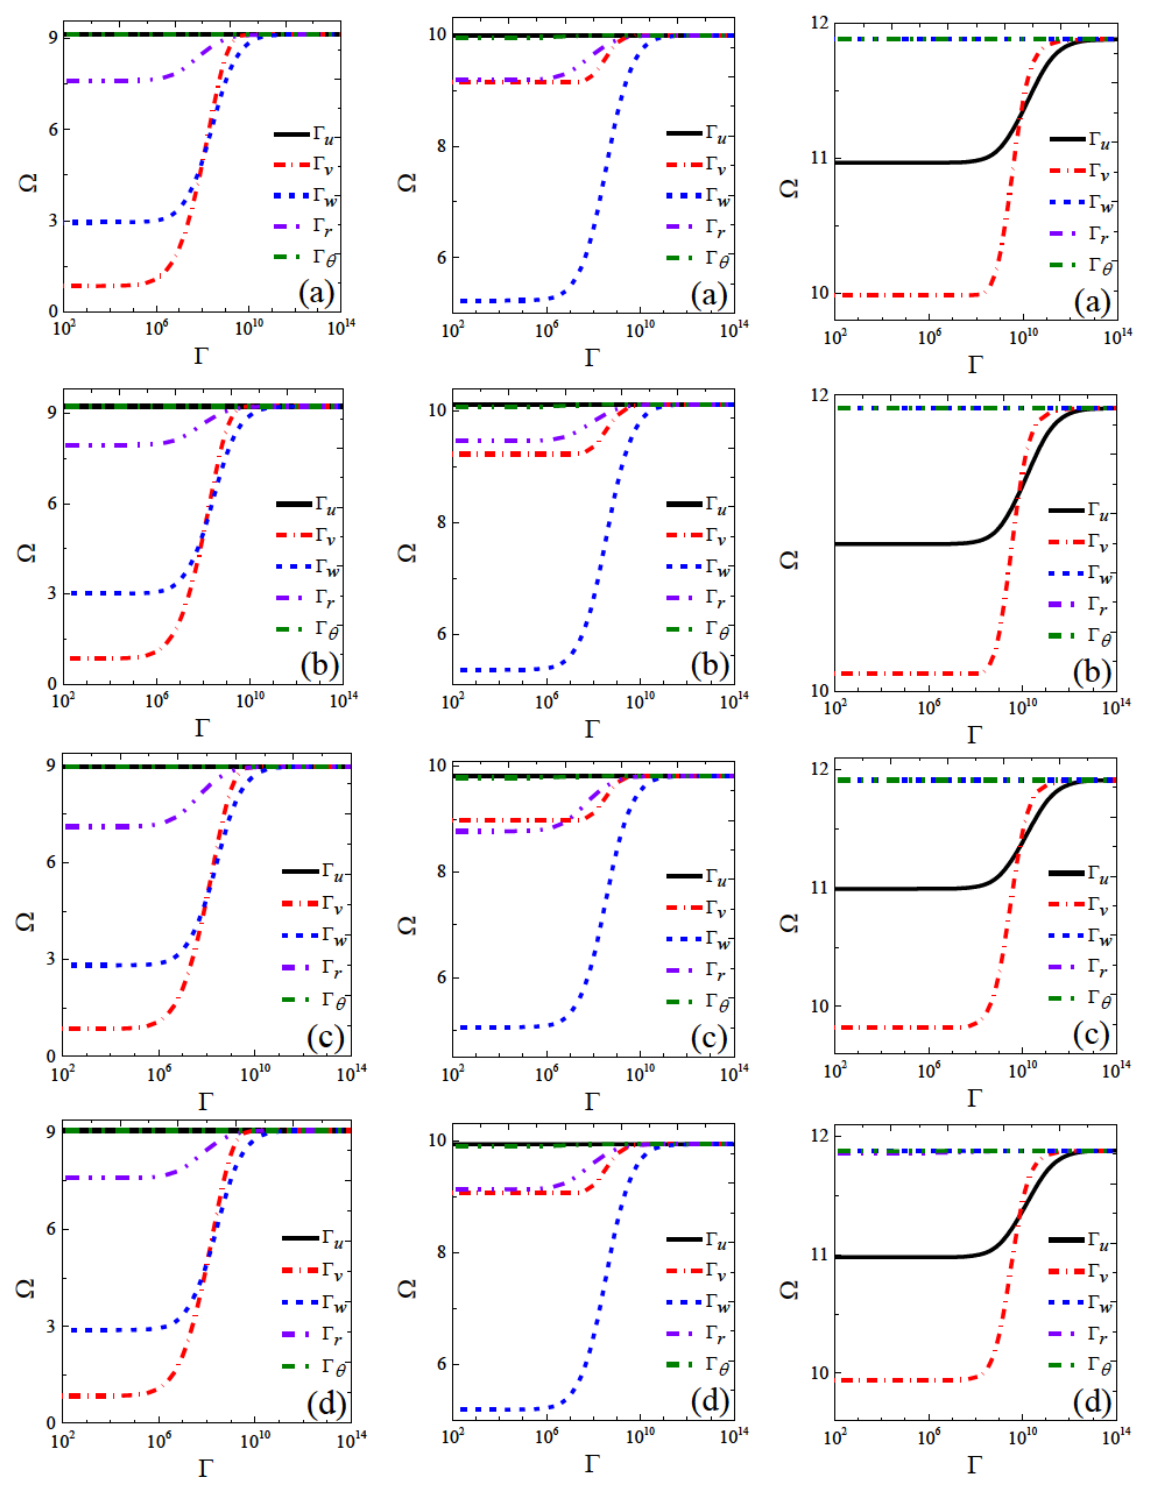
Figure 7: Variation of the first three frequency parameters Ω versus the elastic restraint parameters for FG-CNT reinforced composite annu- lar sector plates:(a) UD-CNT; (b) FGX-CNT; (c) FGO-CNT; (d)